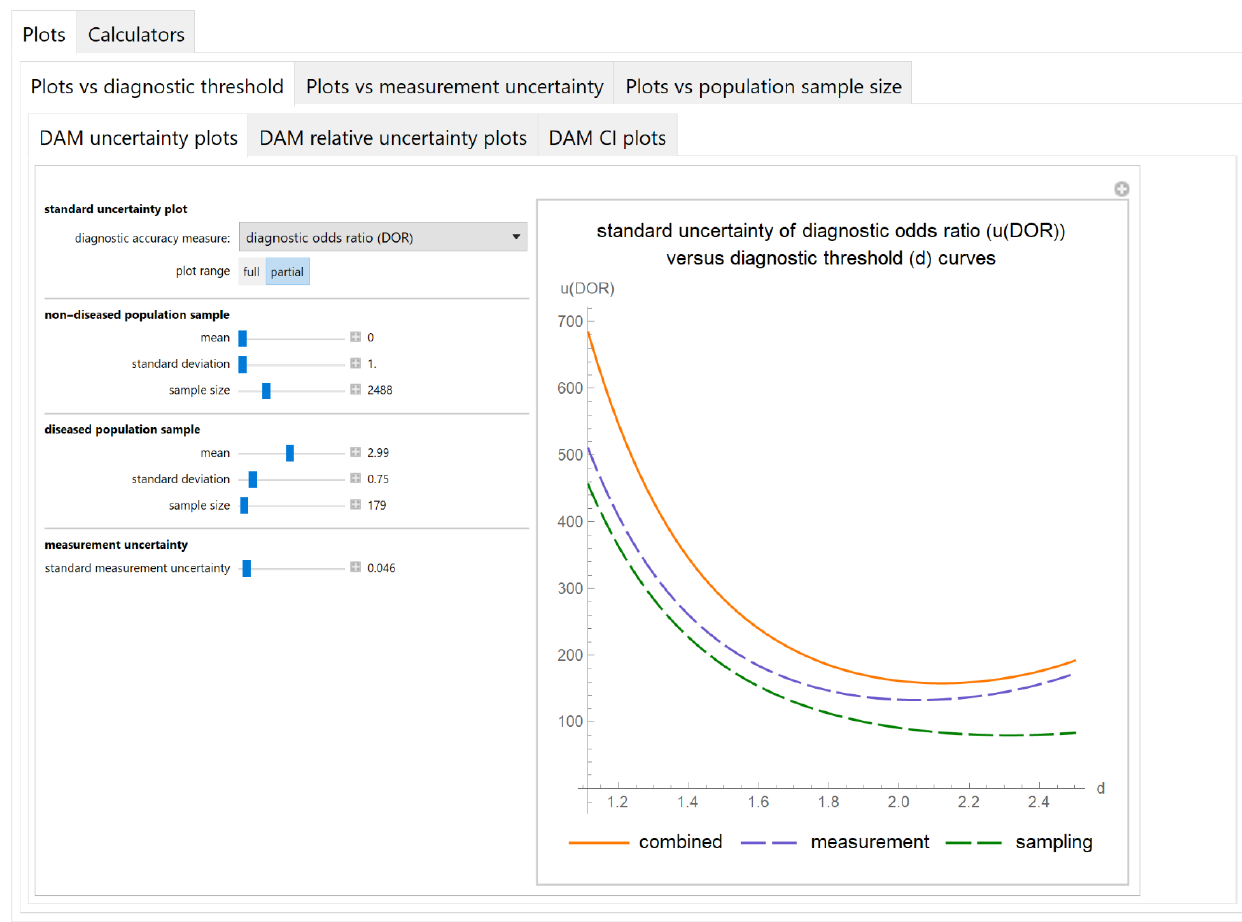
Figure 3. Plots vs. diagnostic threshold module, DAM uncertainty plots submodule screenshot. Standard combined, measurement and sampling uncertainty of diagnostic odds ratio ( u(DOR) ) versus diagnostic threshold ( d ) curve plot, with the settings shown on the left. The respective parameter settings are also shown in Table 3.